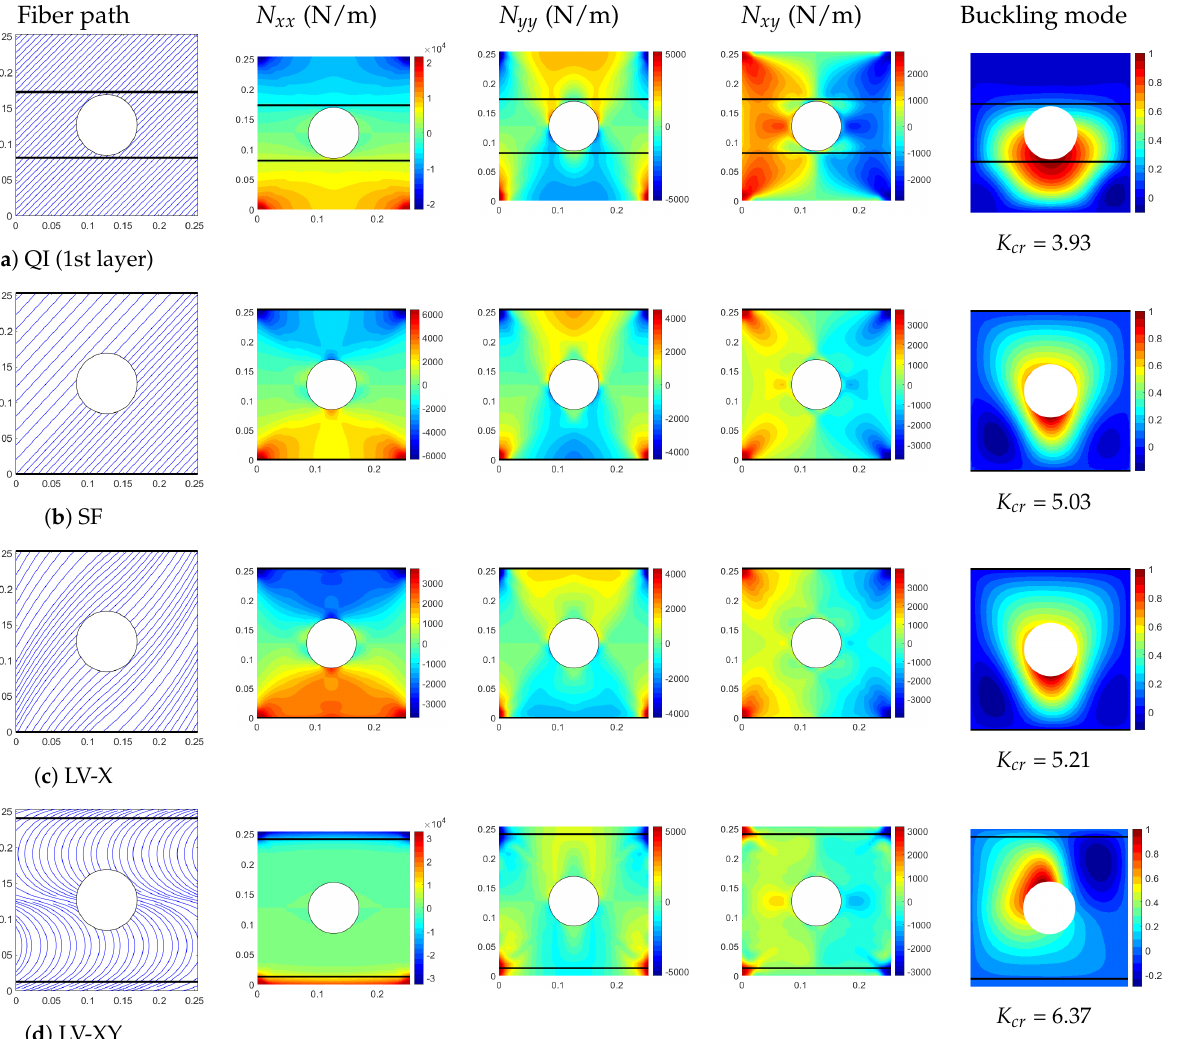
Figure 21. Comparison of optimal fiber paths, stress resultants, and buckling modes for different laminate configuration cases of the stiffened VAT laminates with a central hole under pure in-plane bending displacements. ( a ) QI laminate design; ( b ) SF laminate design; ( c ) LV-X laminate design; ( d ) LV-XY laminate